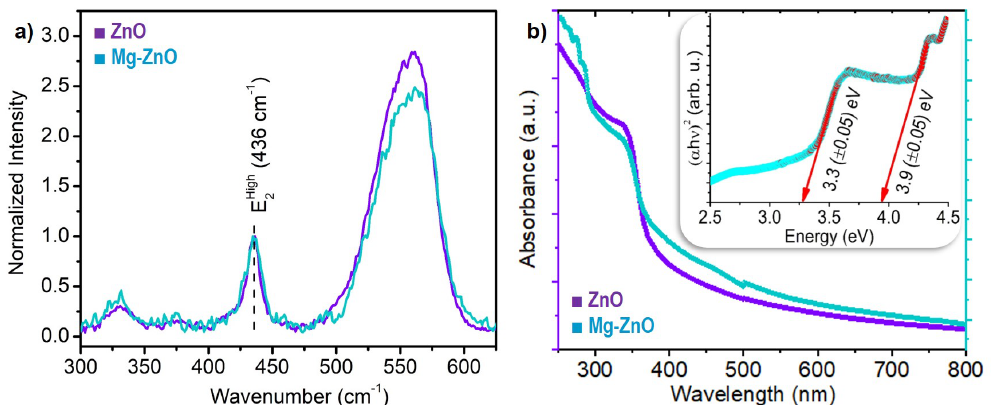
Figure 3. ( a ) Raman spectra of ZnO and Mg-doped ZnO nanoparticles synthesized by the fs-PLAL technique employing an average power of 1.5 W: These spectra were normalized at the E High 436 cm − 1 . ( b ) A comparison of the optical absorption spectra of undoped and doped ZnO nanoparticles. The inset is the Tauc plot for the Mg-ZnO nanoparticles evidencing the band-edge at 3.9 ( ± 0.05 ) eV in addition to the 3.3 ( ± 0.05 ) eV edge of pristine